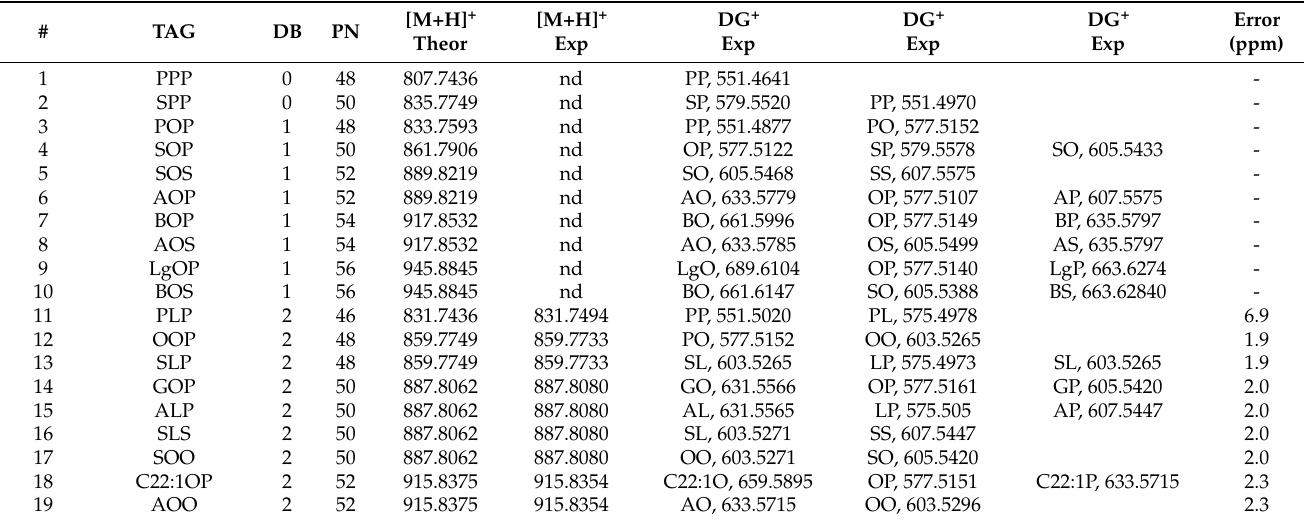
Table 3. Triacylglycerols identified in the borage seed oil, their DB and PN. For each molecule, m/z values of the theoretical protonated molecular ion ([M+H] + theor) and the observed protonated molecular ion ([M+H] + exp), the experimental mass accuracy (error, ppm), and the observed diglyceride ions (DG + exp) are